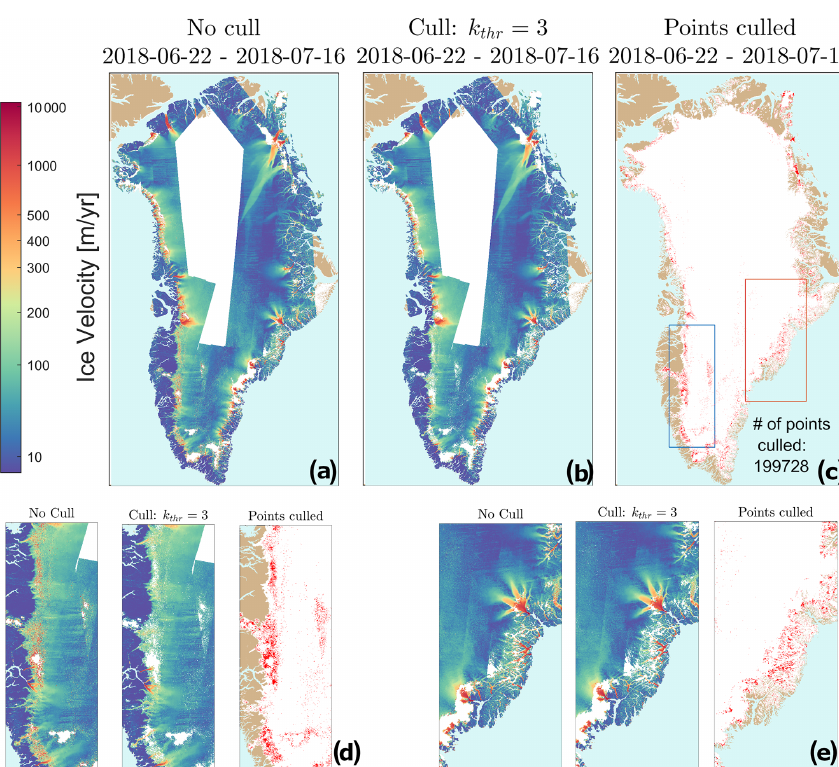
Figure 5. The effect of the culling procedure on the GrIS scale for a map from summer 2018: (a) the ice velocity map with no culling applied. (b) The same ice velocity map with a culling threshold of k thr = 3 applied. (c) The locations of the culled points are shown as red dots. (d) Zoom-in on the blue box in western Greenland. (e) Zoom-in on the red box in eastern Greenland.